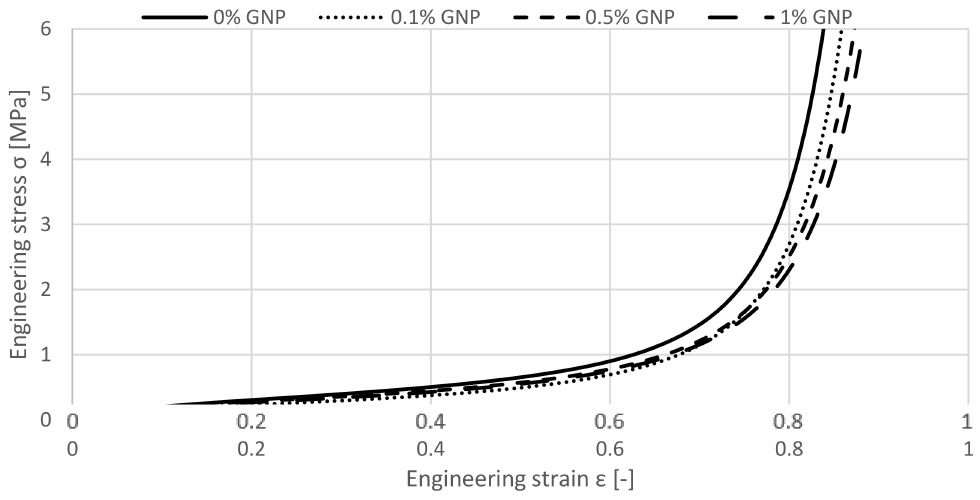
Figure 5. Influence of the GPNs used as a reinforcement on uniaxial quasi-static